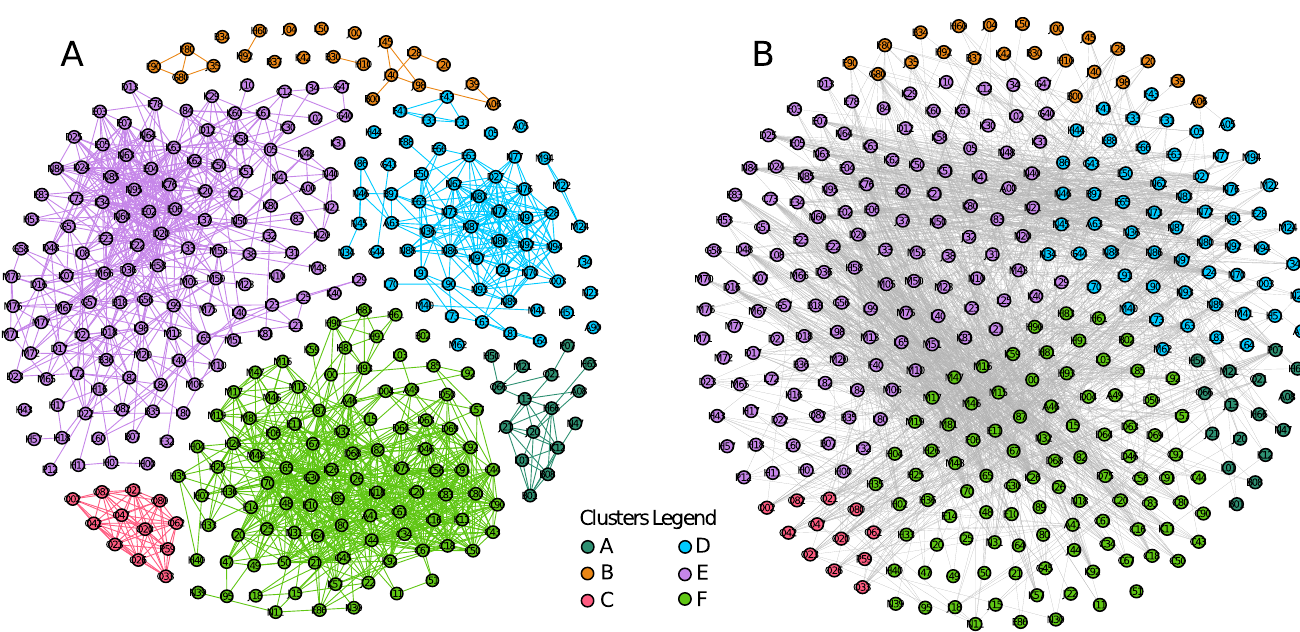
Fig 7. The comorbidity network of highest two thousand values of relative risk (i.e. comorbidity). Nodes in the network are ICD-10 codes and edges represent the relative risk between the disease codes, the edges displayed in the figure belong to the highest two thousand relative risk values for purposes of visualization. Edges in the network (A) show intra-cluster comorbidities and edges in network (B) shows the inter-cluster comorbidities.